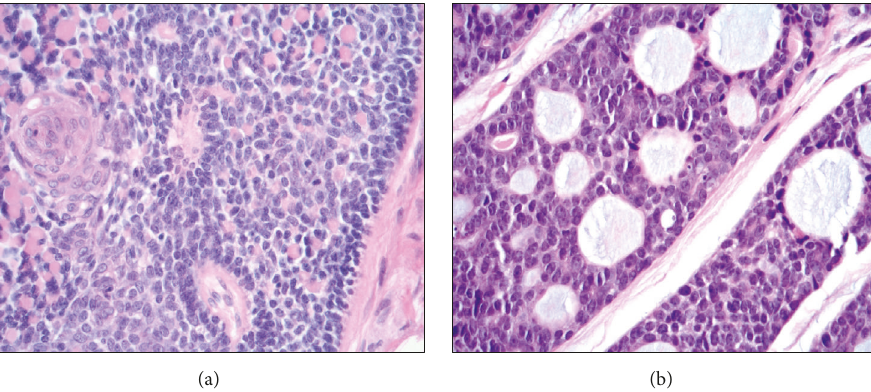
Figure6:Histopathologiccomparisonofcylindromawithadenoidcysticcarcinoma:(a)highmagnificationofcutaneousadnexalcylindroma ofthebreastshowingsmall,dense,andeosinophiliccylindersofbasementmembranematerialsprinkledthroughoutanepithelialisland,H&E stain, 400x; (b) high magnification of a comparison case of mammary adenoid cystic carcinoma with a cribriform growth pattern and larger amphophilic accumulations of basement membrane material, H&E stain,